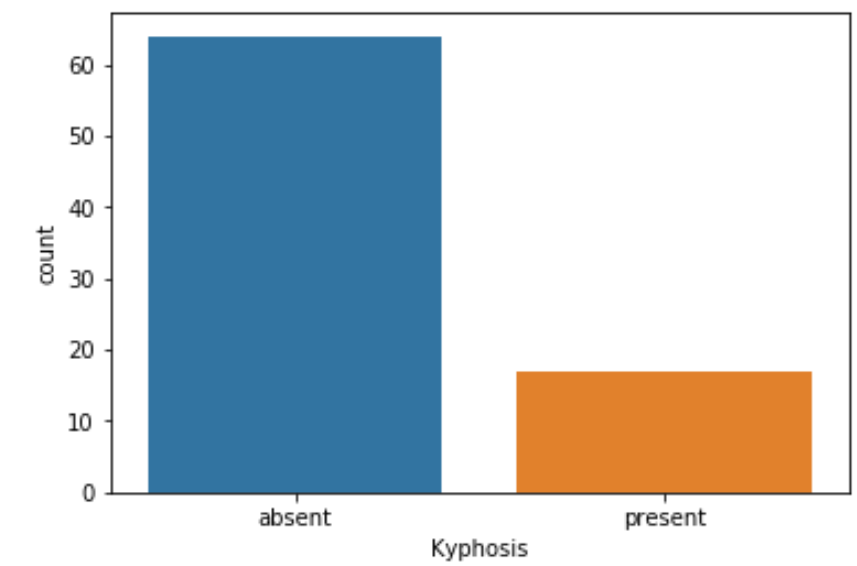
Figure 11. The distribution of the kyphosis disease representing absent or present.